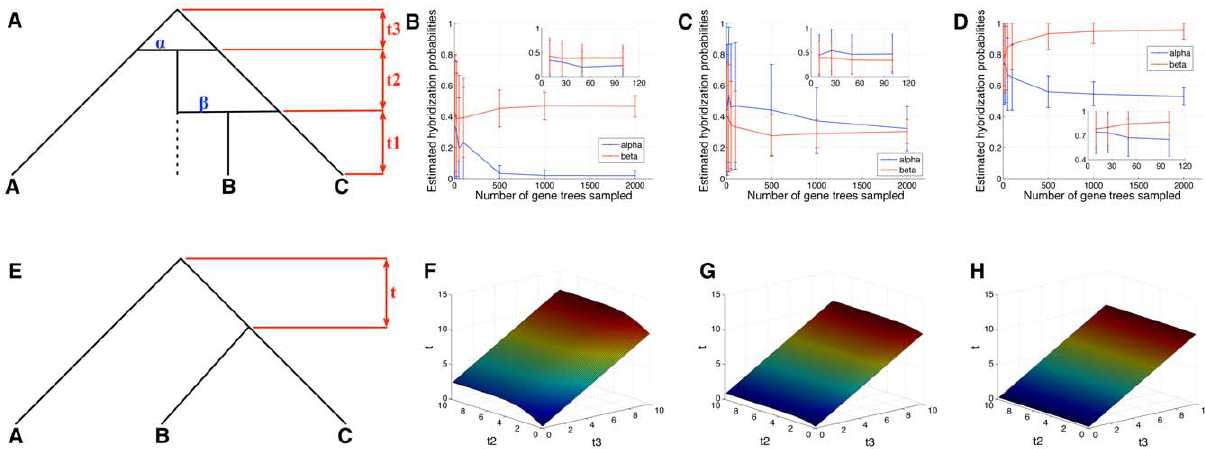
Figure 4. Identifiability in detecting hybridization. (A) A phylogenetic network with two hybridization probabilities, where the second hybridization involves the first hybrid population, and extinction is involved. (B–D) Estimates of a and b , as a function of the number of gene trees used, when the true values of t 1 ~ t 2 ~ t 3 ~ 1 : 0 are assumed in the inference, and for true ( a , b ) values of (0 : 0,0 : 5) , (0 : 3,0 : 3) , and (0 : 5,1 : 0) , respectively (insets zoom in on the left parts of the figure). (E) A phylogenetic tree with three taxa, and with divergence time t between the two speciation events. (F–H) The value of t for the tree in (E) that yields the same probability of the data under the scenario depicted in (A) when a ~ 0 : 0 , as a function of t 2 and t 3 , and for b value of 0 : 1 , 0 : 5 , and 0 : 9 , respectively. Since a single allele was sampled per species, the data is uninformative for estimating the value of